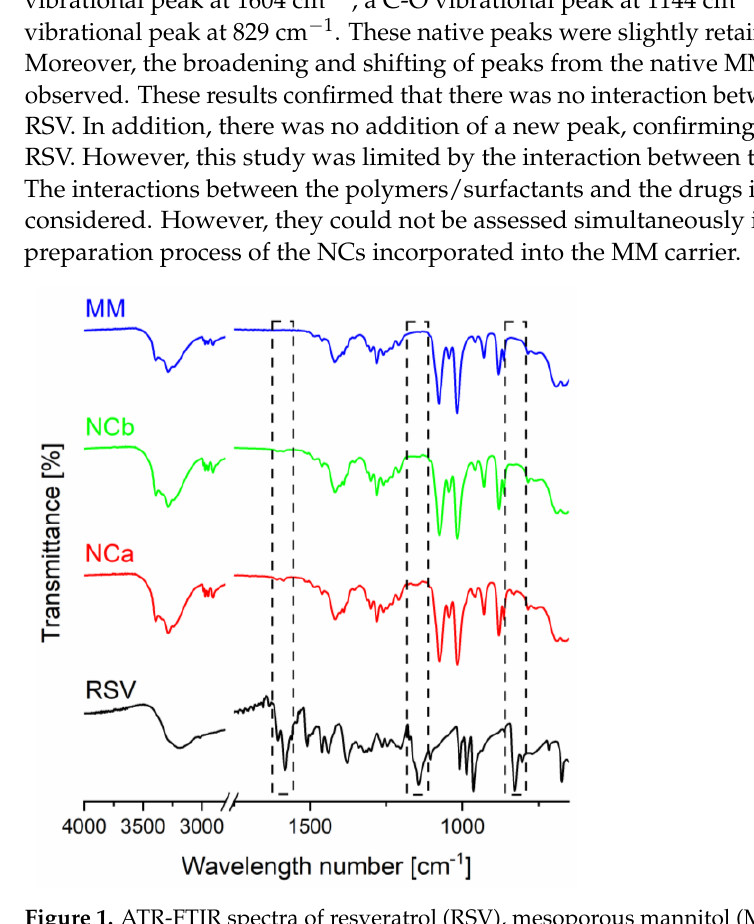
Figure 1. ATR-FTIR spectra of resveratrol (RSV), mesoporous mannitol (MM), nanocrystal incorpo- rated into mesoporous mannitol (NC; NCa, and NCb for Runs 15 and 12, respectively). The thermal profiles of the RSV, MM, and NCs are depicted in Figure 2. The RSV featured a sharp endothermic peak at 268.4 ◦ C, corresponding to the melting phenomenon, followed by decomposition. It lost about 40% of its mass during heating at 400 ◦ C. The thermal MM featured a relatively broad endothermic peak at 179 ◦ C and an overlaid peak at 174.9 ◦ C. It was affected by the mannitol’s amorphous form during the spray drying process. In addition, it underwent a decomposition of 88% at 365.4 ◦ C. A narrower peak than that of the MM was observed in the NC thermogram. However, different drug loadings exerted different effects on the thermogram. Higher drug loadings created sharper endothermic peaks. The NCa melted at 173 ◦ C. Meanwhile, the NCb displayed an endothermic peak at 165.7 ◦ C. There was an interaction between the system and the carrier, i.e., the thermal stability changed along with a decomposition of 85% around 390 ◦ C. In addition, different drug loadings shifted the melting point of the carrier. These interactions were limited by the physical interaction of the attachment of the nanoparticle crystal in the surface of the MM. Therefore, the interaction was not observed in the FTIR results (molecular interaction).